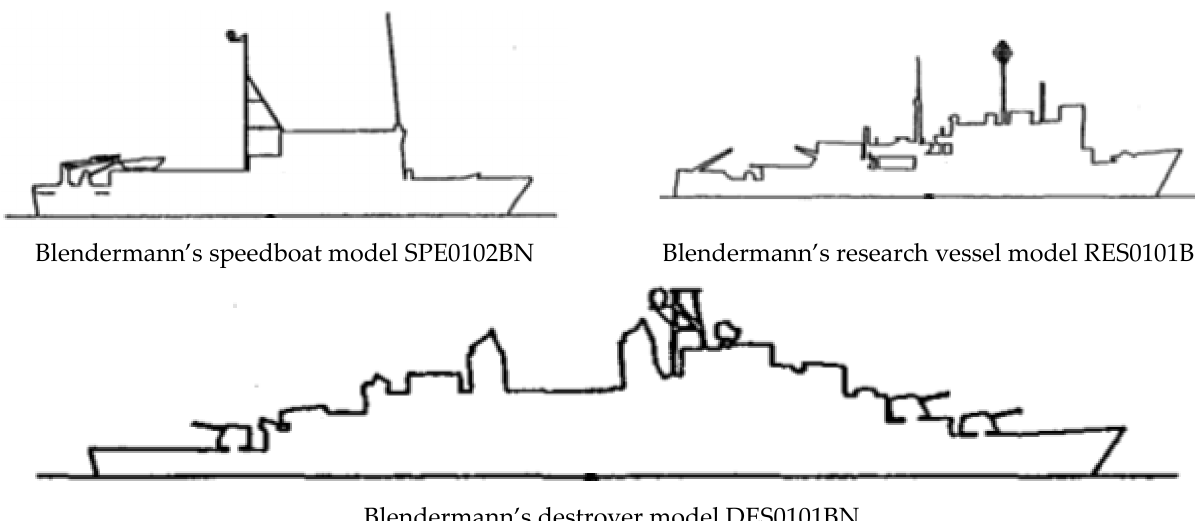
Figure 14. Hull models used for comparison of results. The hull forms are well described in the paper by Blendermann [13].